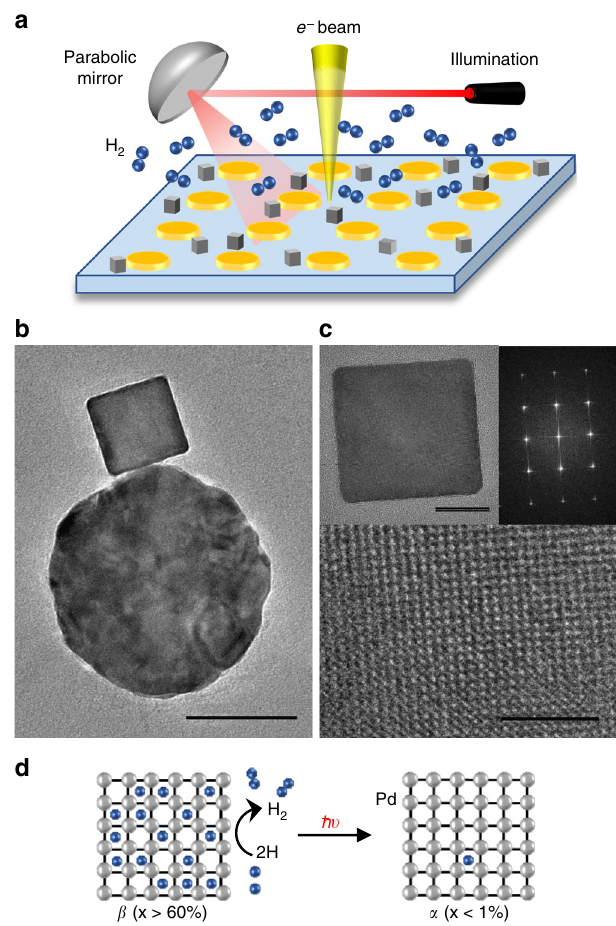
Fig. 1 Plasmon-induced phase transformation in the antenna-reactor con fi guration. a Schematic of the light-coupled environmental transmission electron microscope (ETEM) with an Au nanodisc array and Pd nanocubes on a Si 3 N 4 membrane. b Representative TEM image of an antenna-reactor pair. Scale bar is 50 nm. c Aberration-corrected TEM image of a representative single-crystalline Pd nanocube on an ultrathin carbon substrate, including a zoomed-in view of the lattice and its corresponding Fourier transform. Scale bars are 10 nm and 2 nm respectively. d Schematic of the β to α phase transformation reaction under